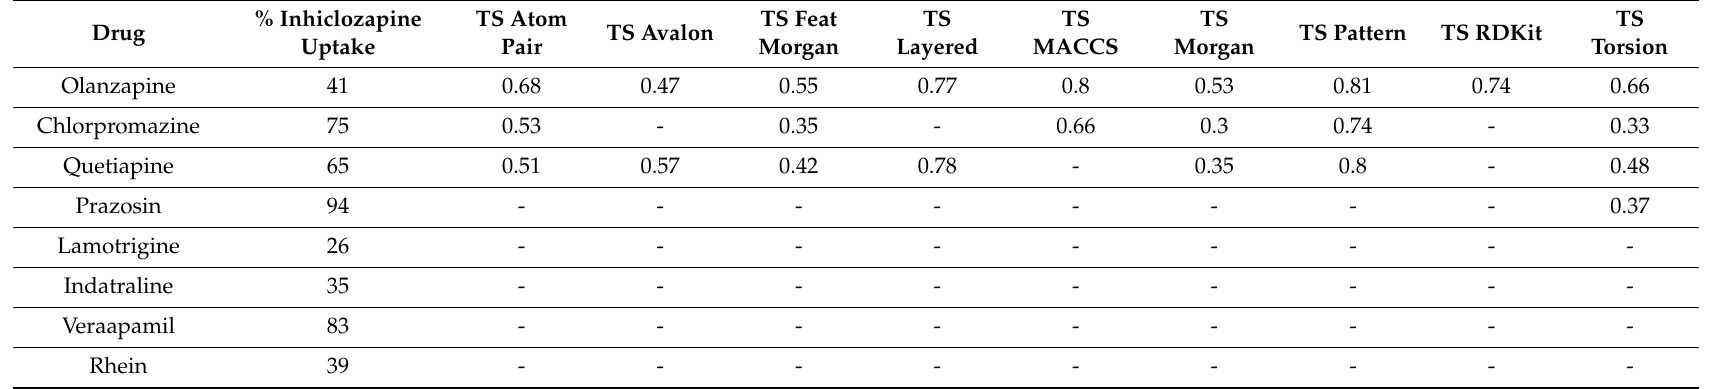
Table 1. Tanimoto similarity to clozapine using nine di ff erent RDKit encodings and their ability to inhibit clozapine transport (data extracted from [26]). A shaded cell means that the molecule was not judged to be in the “top 50” using that